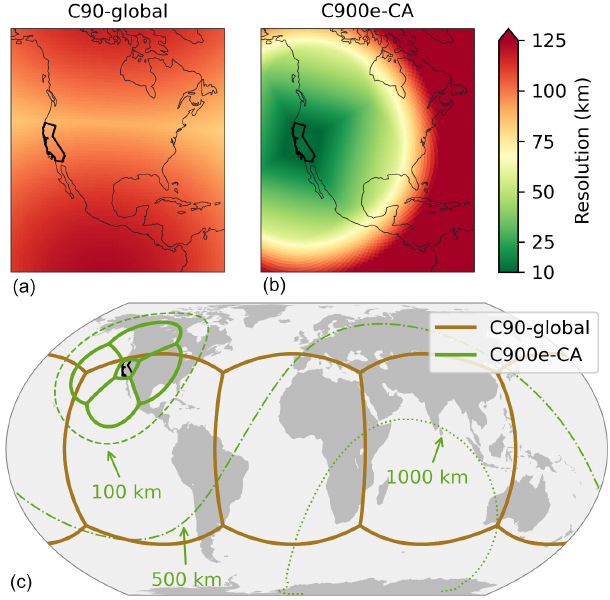
Figure 8. Comparison of C90-global and C900e-CA grids. The top panels show the variability of resolution for both grids. The bottom panel shows the grid face edges for C90-global and C900e-CA, with the 100, 500, and 1000km resolution contours for